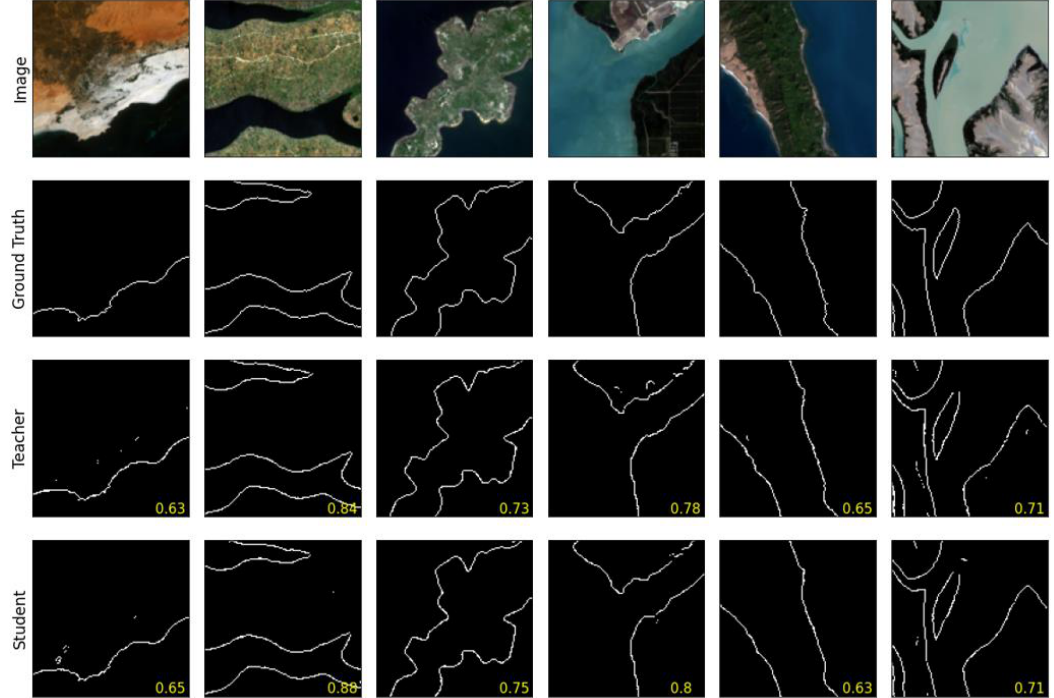
Figure 2. Results on Landsat data. The rows are RGB image, ground truth, teacher model’s prediction, and student model’s prediction. The F-score for an individual image can be in the bottom right corner.